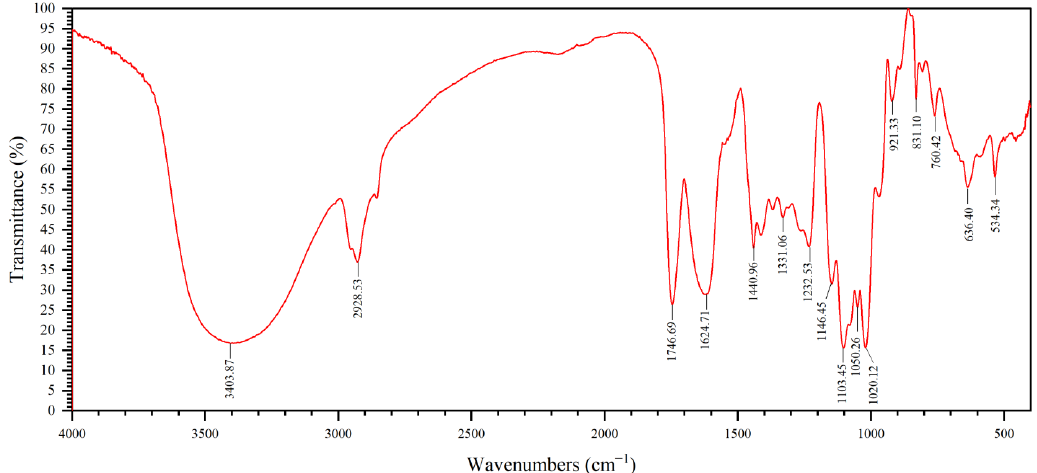
Figure 2. Fourier-transform infrared (FTIR) spectrum of GP2a. Bands positions are indicated in cm −1 .